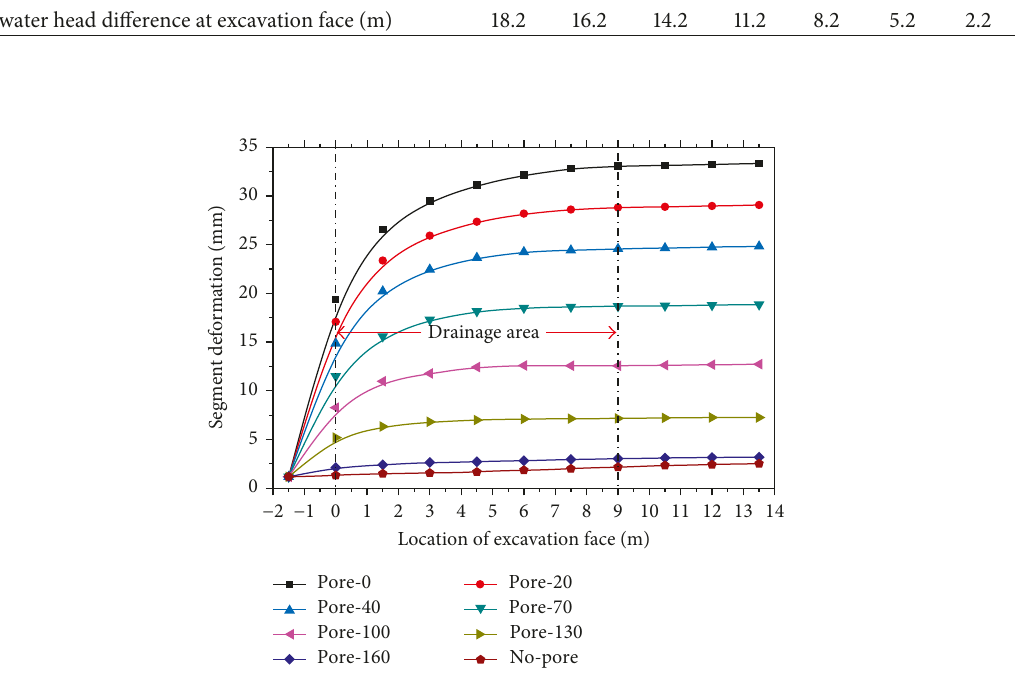
Figure 12: The maximum deformation of